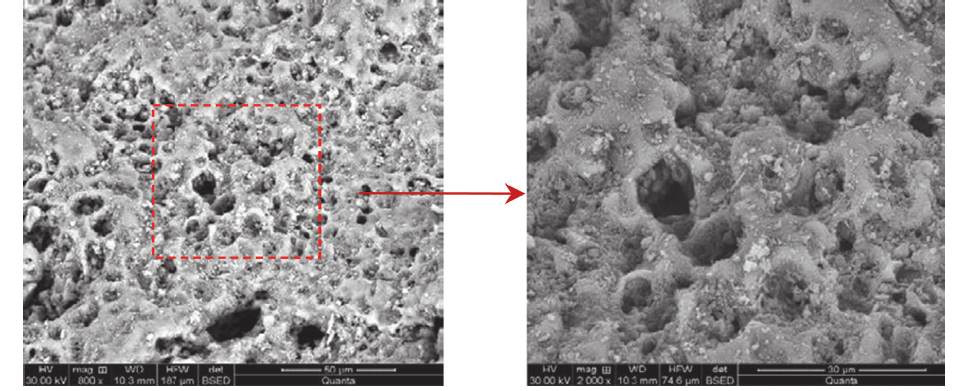
Figure 1: SEM image of calcareous